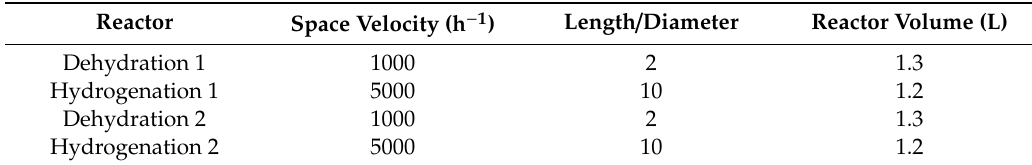
Table 2. Parameters used for reactor